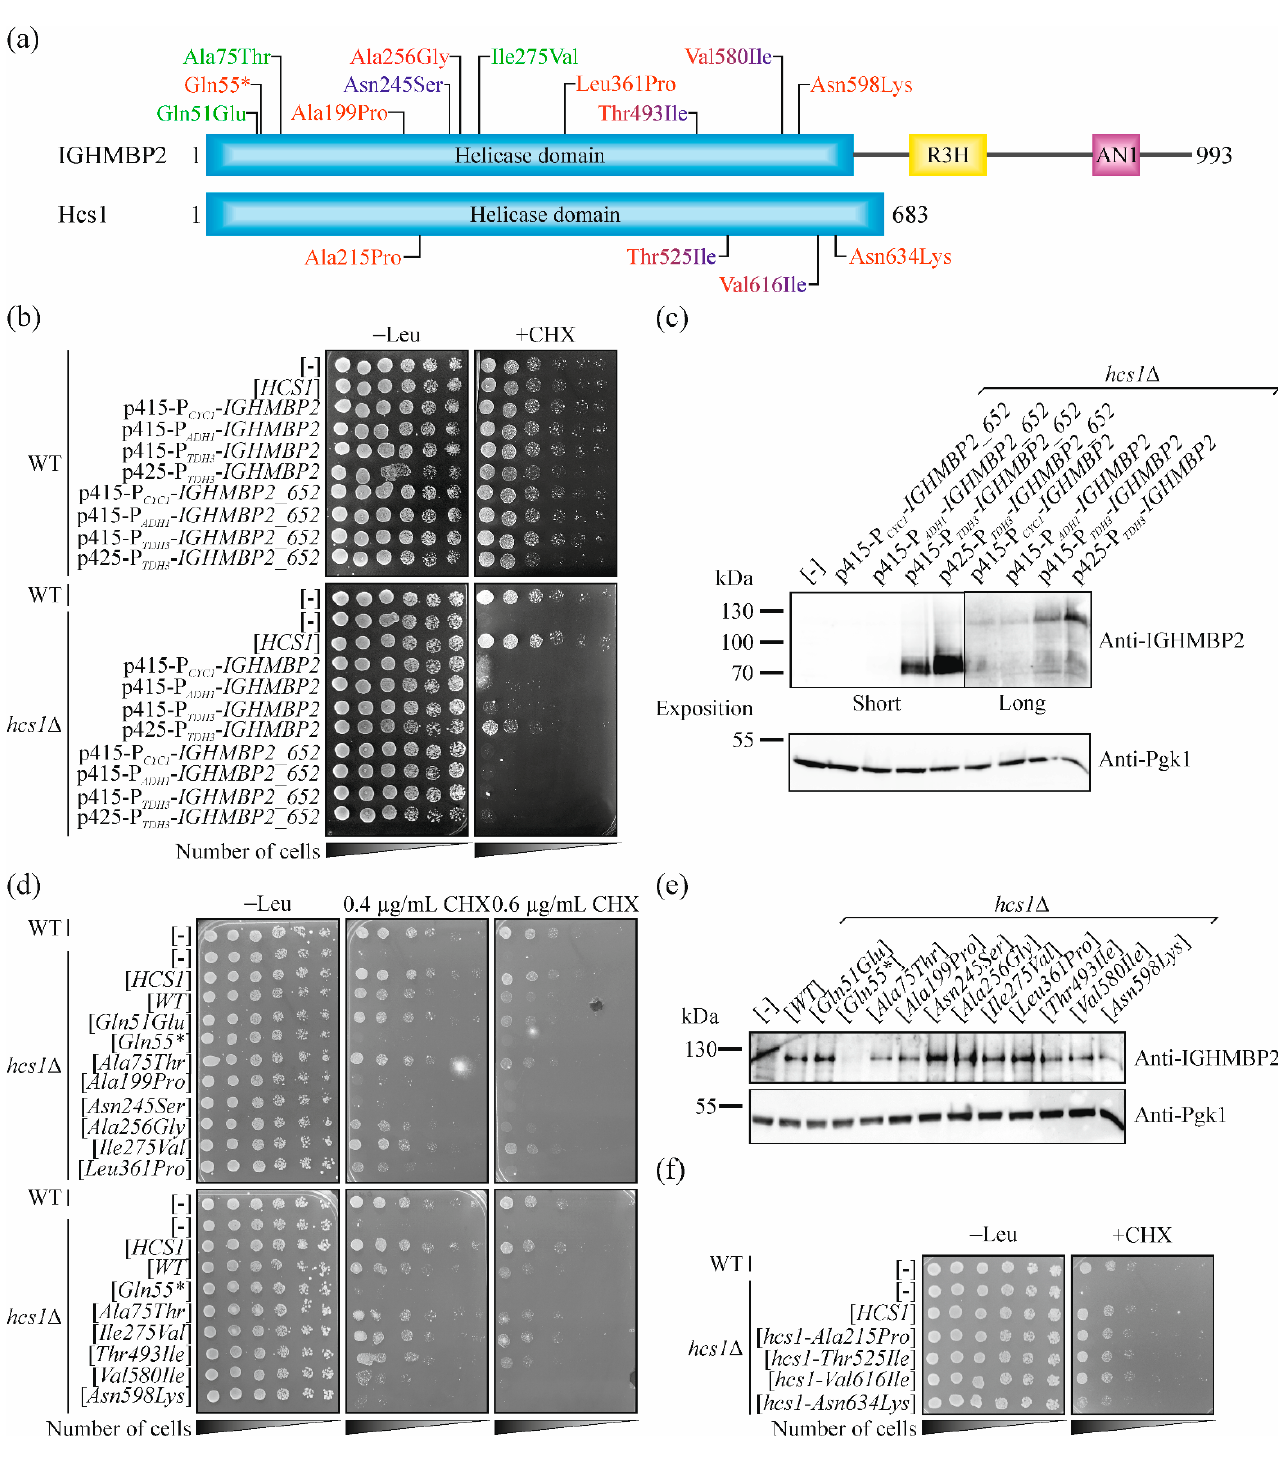
Figure 3. Expression of human IGHMBP2 cDNA suppresses the growth defect of hcs1 Δ strains on a cycloheximide-containing medium, while the introduction of pathogenic mutations impair this ability. ( a ) Schematic representation of human IGHMBP2 and yeast Hcs1 domain structure; helicase domain, blue; R3H, yellow; AN1-type zinc finger motif (AN1), pink; amino acid residue substitutions in IGHMBP2 proteins in SMARD1-affected patients, red; amino acid residue substitutions in CMT2S, navy blue; benign changes, green. The p.Thr493Ile and p.Val580Ile found in both SMARD1 and CMT2S patients are indicated in red and navy blue (similar to their equivalents in Hcs1, p.Thr525Ile and p.Val616Ile). Substitutions in IGHMBP2 are indicated above and their equivalents in Hcs1 below scheme. ( b ) Suppression of the growth phenotype of hcs1 Δ yeast cells by full-length and truncated versions of IGHMBP2 with different expression levels.